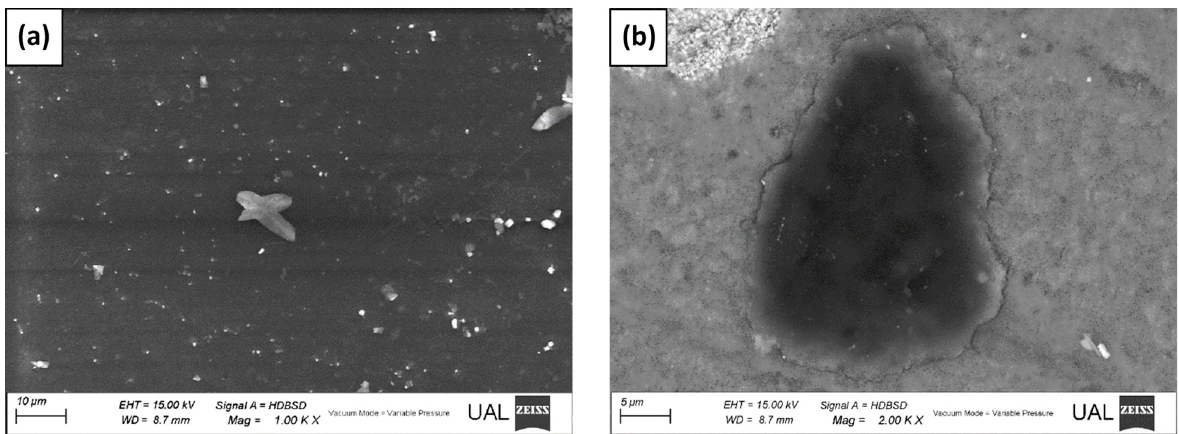
Figure 4. SEM images of the membrane after 6 h of filtration ( a ) and after cleaning for 3 h under b simulated solar irradiation ( b ). simulated solar irradiation (